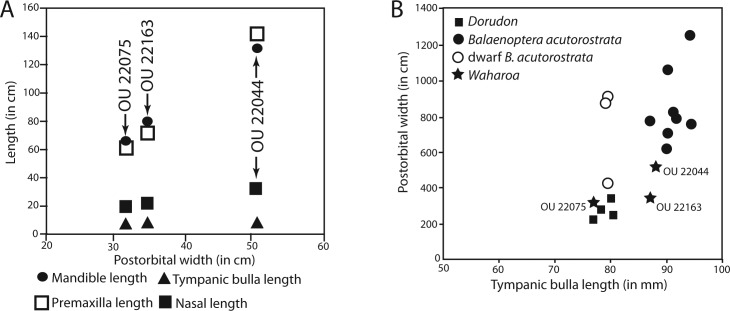
Ontogenetic change in rostral, mandibular, and tympanic bulla length in Waharoa ruwhenua.(A) Relative length of premaxilla, nasal, mandible, and tympanic bulla as compared to postorbital width. (B) Length of tympanic bulla relative to postorbital width of Dorudon atrox (measurements from Uhen (2004)), Balaenoptera acutorostrata and B. bonaerensis (Omura, 1957; Omura, 1975; and specimens reported by Watson & Fordyce, 1993), dwarf Balaenoptera acutorostrata (Arnold, Marsh & Heinsohn, 1987; Paterson et al., 2000; Secchi et al., 2003), and Waharoa ruwhenua. Bizygomatic width measurements from literature used instead of postorbital width for Balaenoptera acutorostrata to maximize available samples.